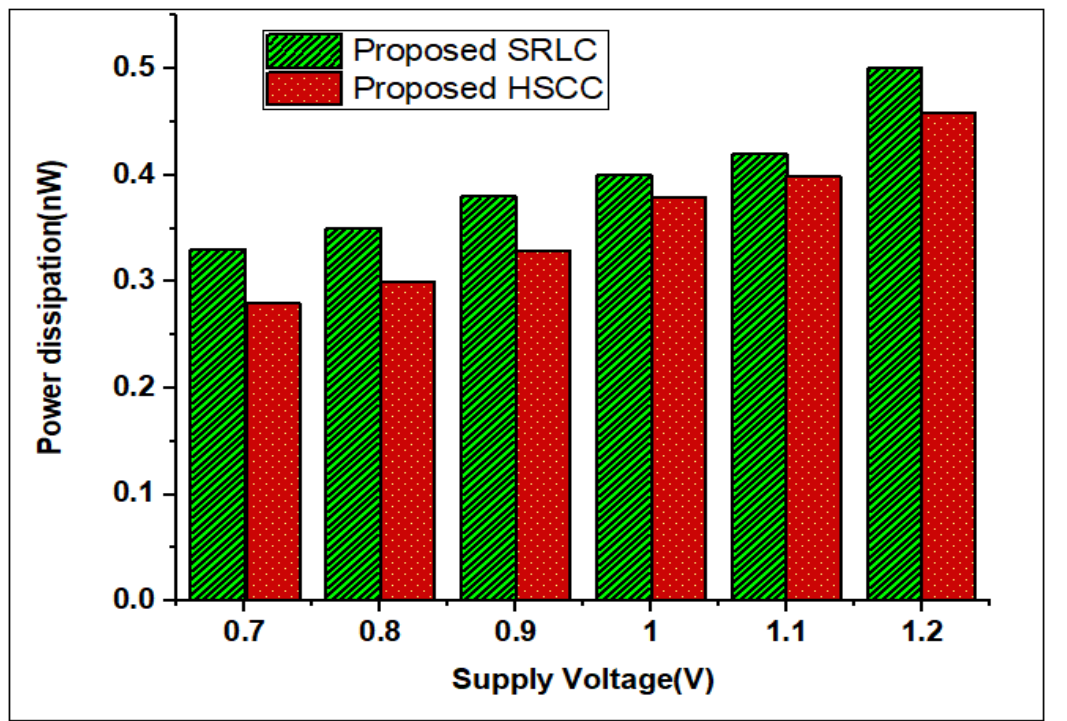
Figure 17. Simulation of power dissipation with a supply voltage of FinFET-based circuits at 7 nm.